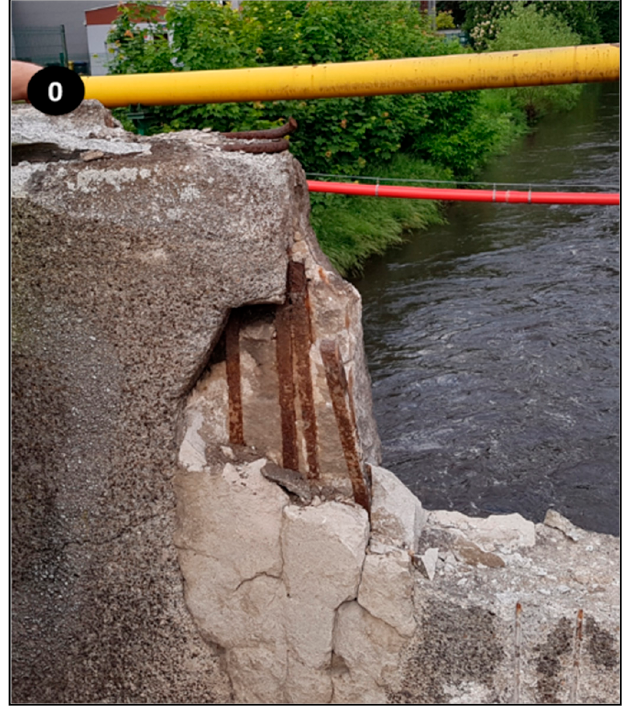
Figure 8. Corroded steel bars in the concrete of the balustrade.